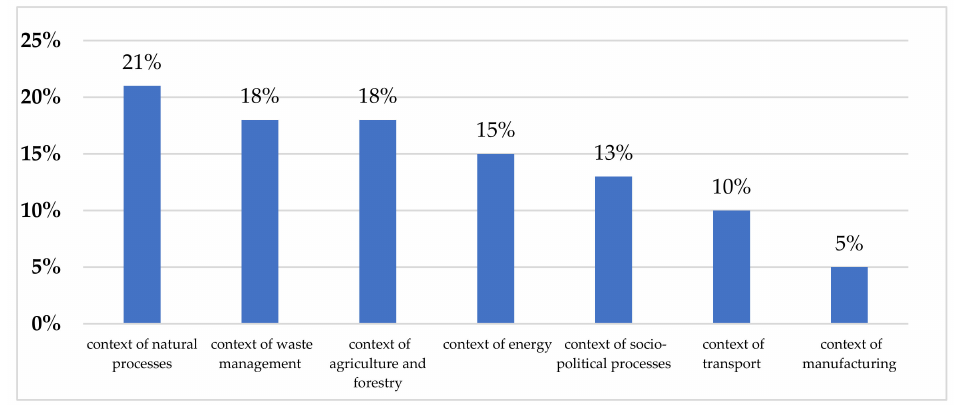
Figure 2. Context of reflection on climate change in EP pre-election